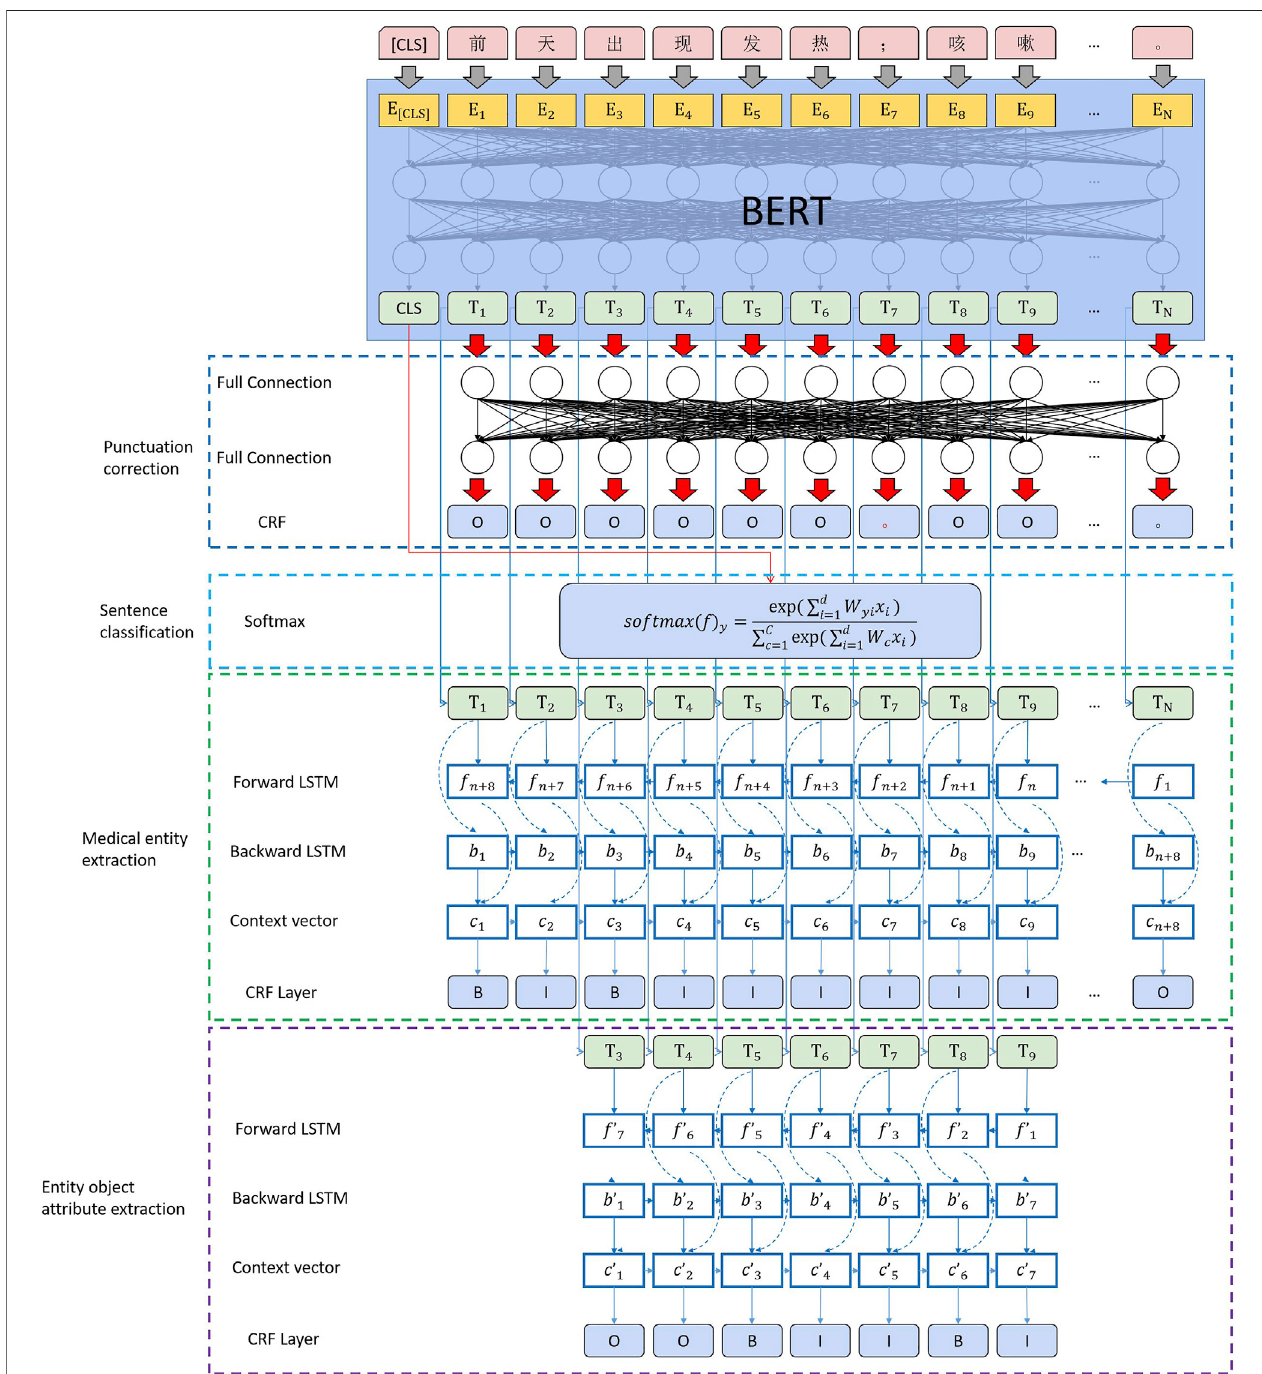
FIGURE 8 | MLEE computing